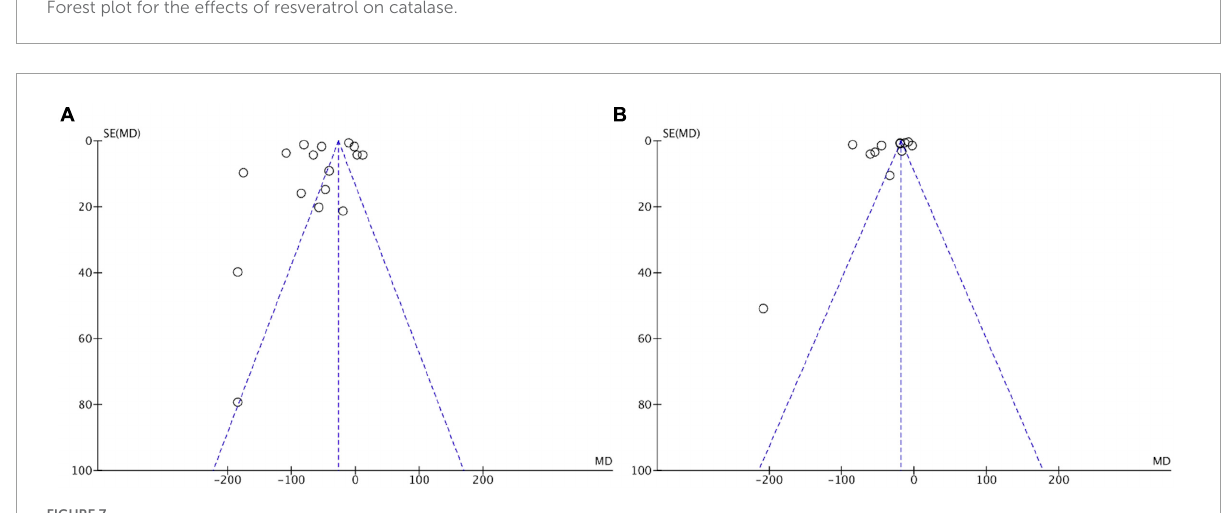
FIGURE7 Funnel plots on publication bias for serum creatinine (A) and blood urea nitrogen (B) .